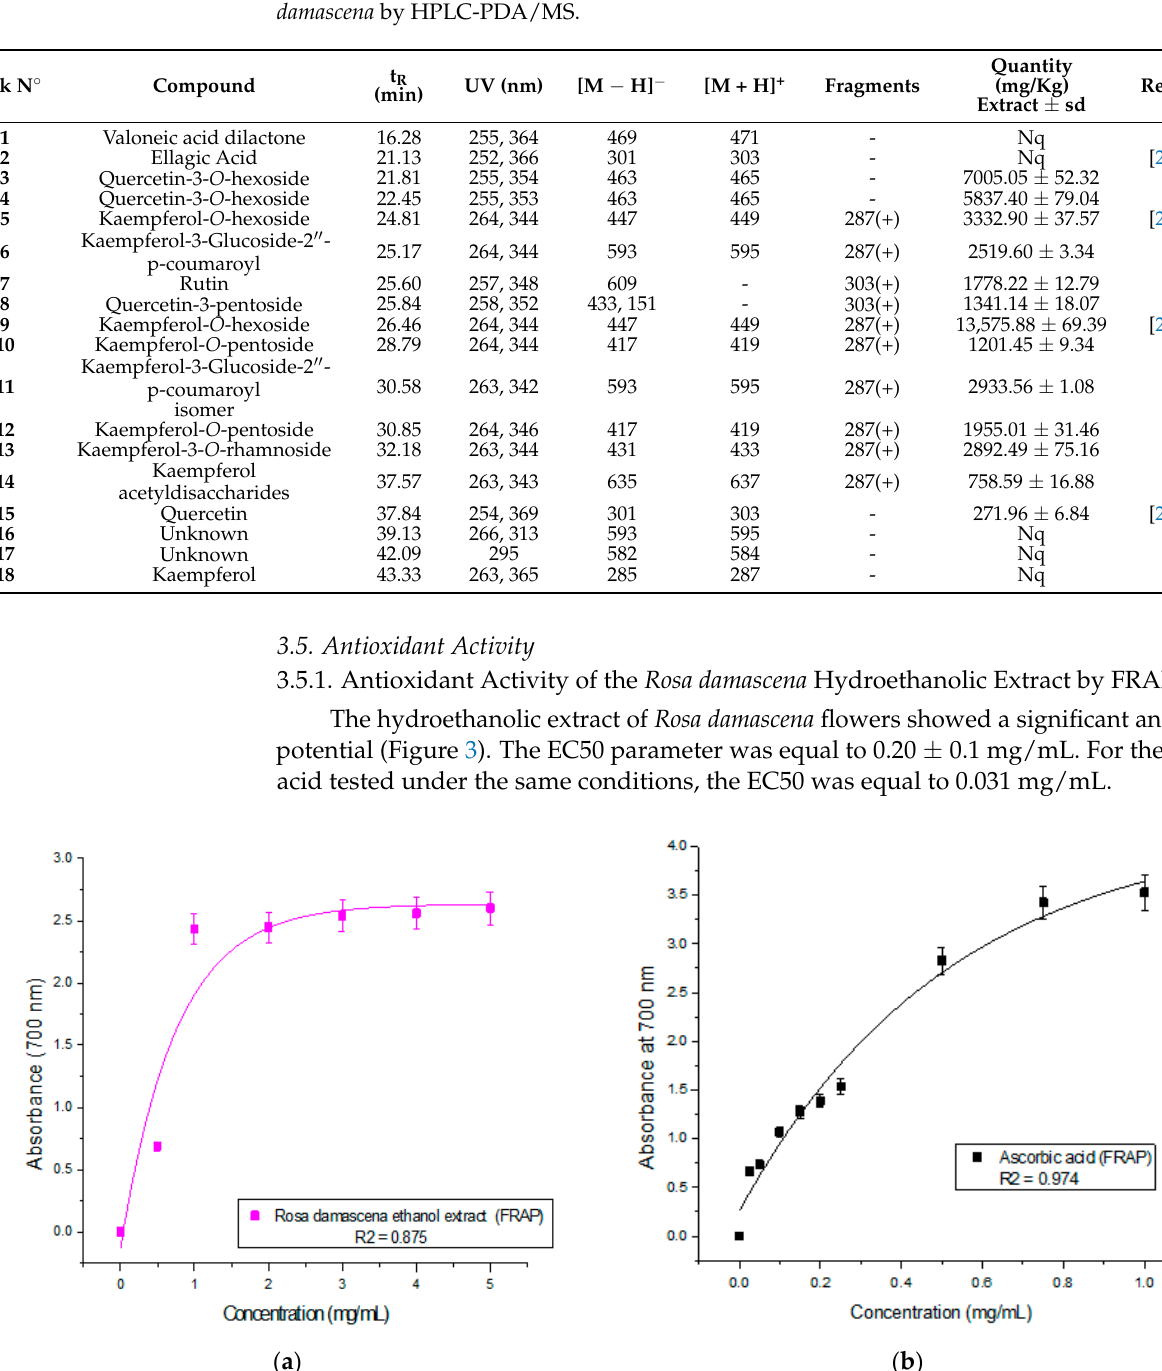
Fe(II)) [43]. Dudonné et al. reported a ferric reducing power of the aqueous extract of Rosa